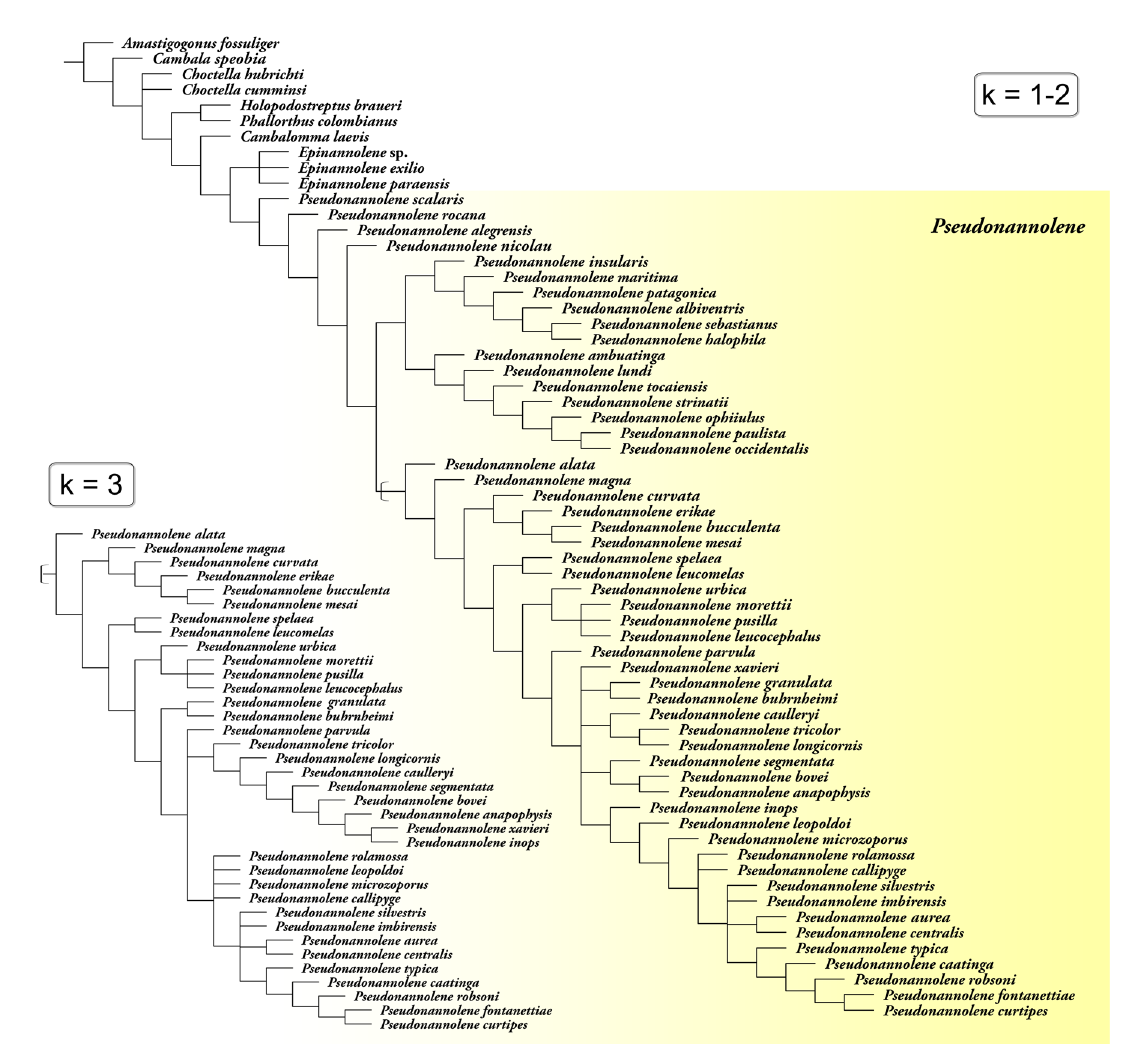
Fig. 6. Strict consensus of equally parsimonious trees under implied weighting ( k = 1–2 and